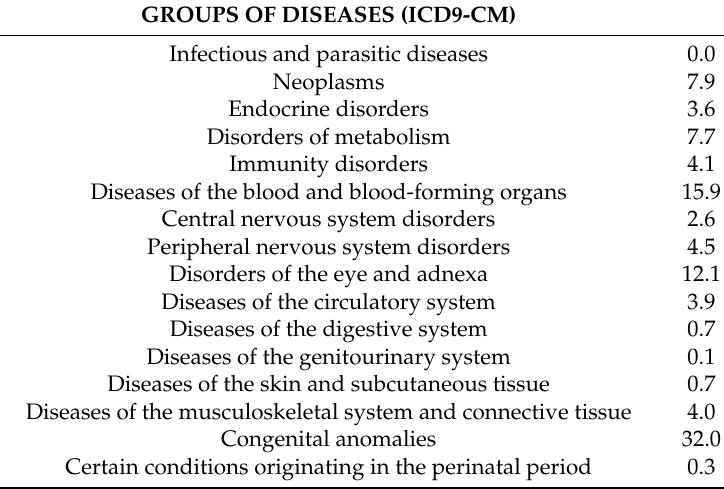
Table 1. Percentage distribution per nosological group (ICD-CM) of patients experiencing transition. Veneto region rare diseases registry; 2006–2016.